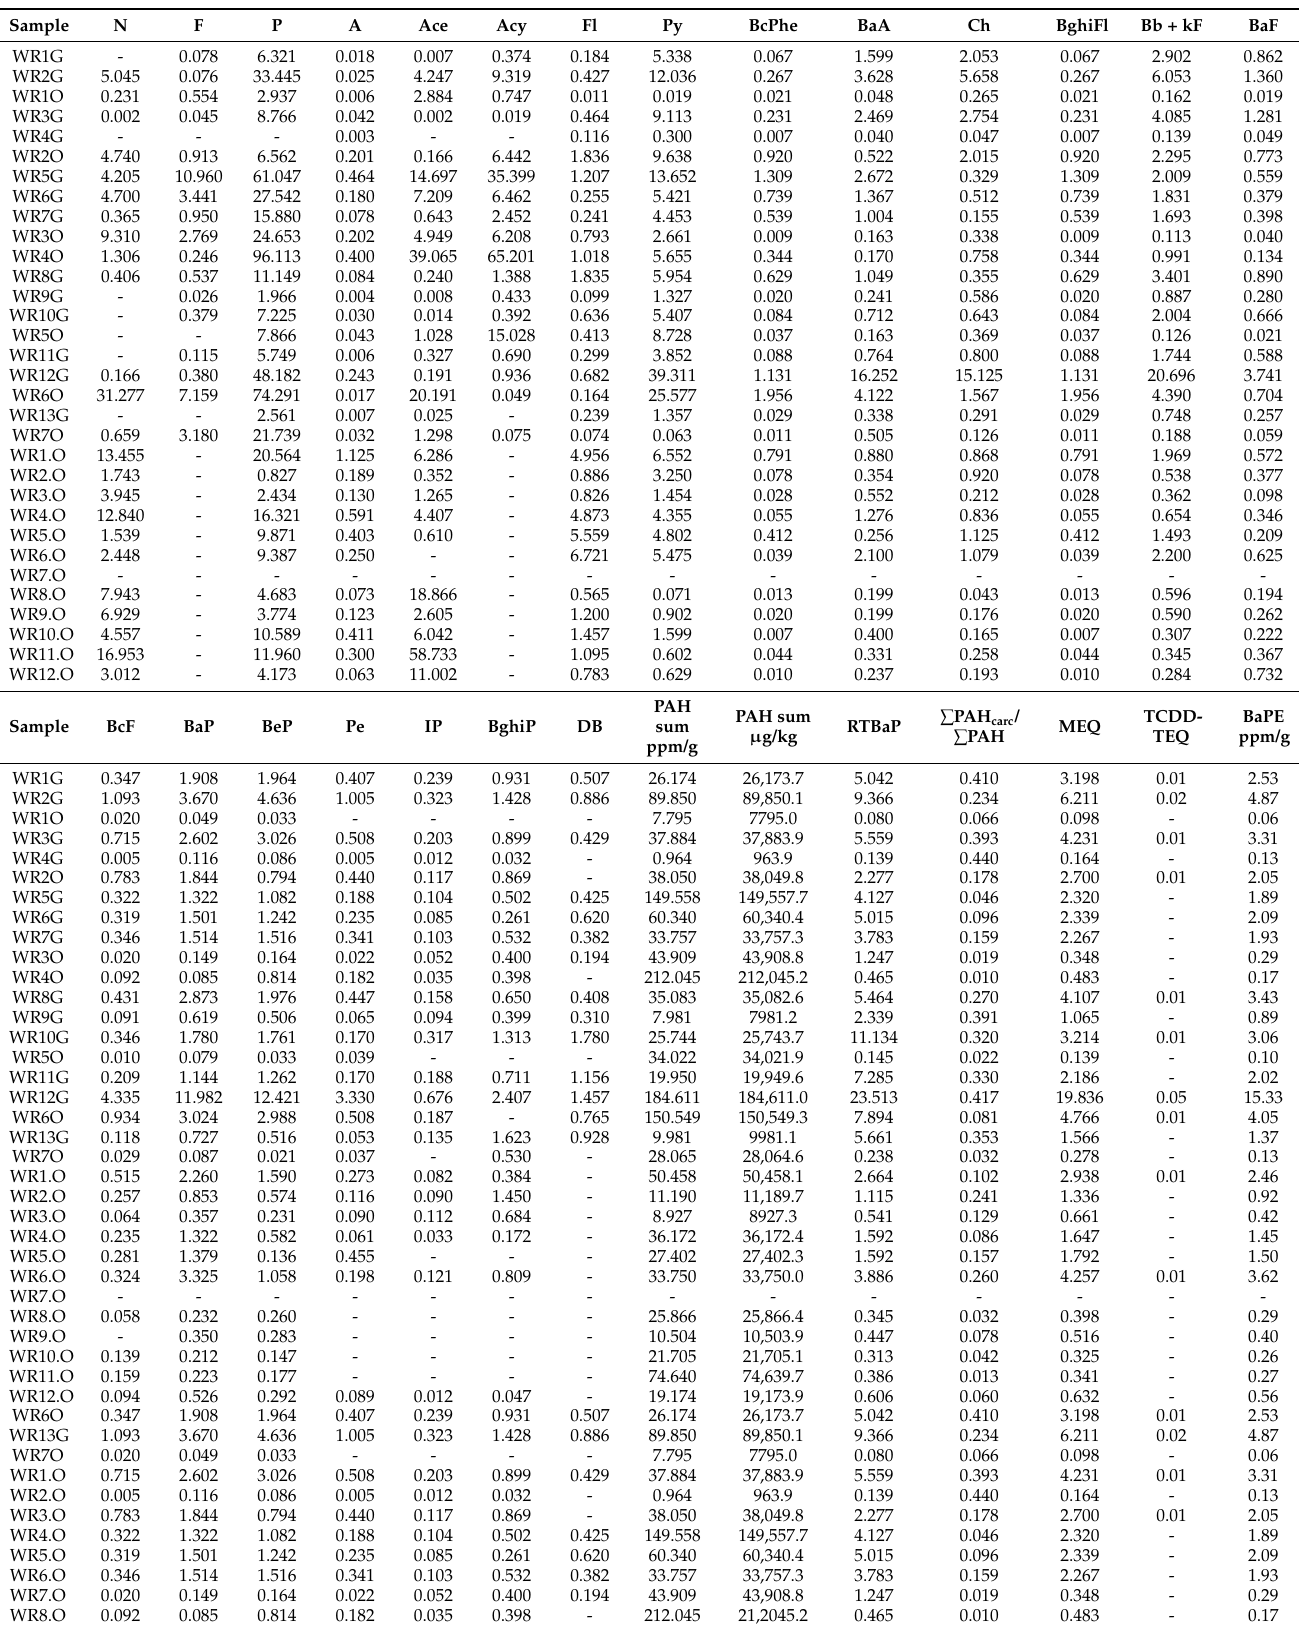
Table 2. Polycyclic aromatic hydrocarbon concentrations in the Trzebinia samples